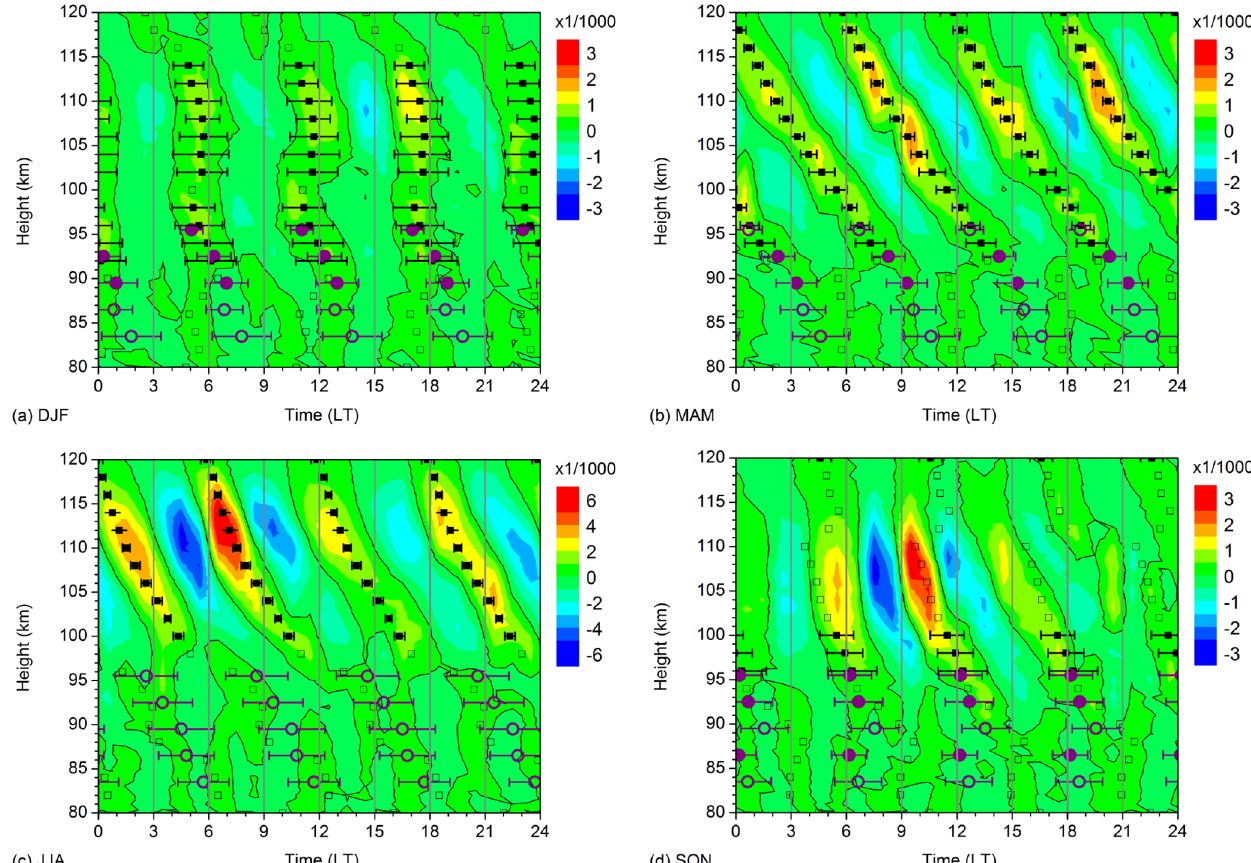
Figure 6. 2007–2016 mean seasonal mean diurnal cycle of Es residual occurrence rates after removing diurnal mean, 8, 12, and 24h components for (a) DJF, (b) MAM, (c) JJA, and (d) SON in a latitude band 46–56 ◦ N and in height gates of 10km. Note the different scaling for JJA; 6h phases of OR and Collm wind shear are added as squares and circles, respectively. Solid symbols denote oscillations significant at the 5% level according to a t -test. The error bars show standard deviations calculated from phases for single years.